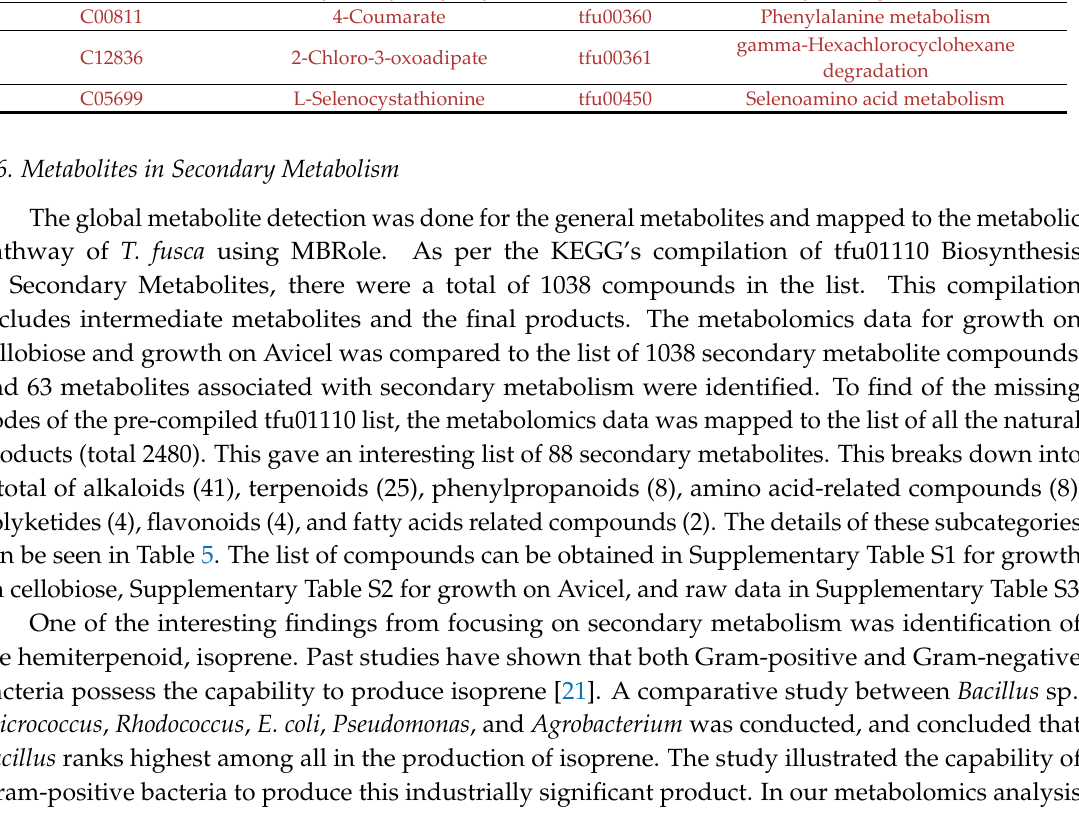
Table 5. Distribution of Secondary Metabolites as detected in each of the growth conditions of cellobiose (Cb) and Avicel